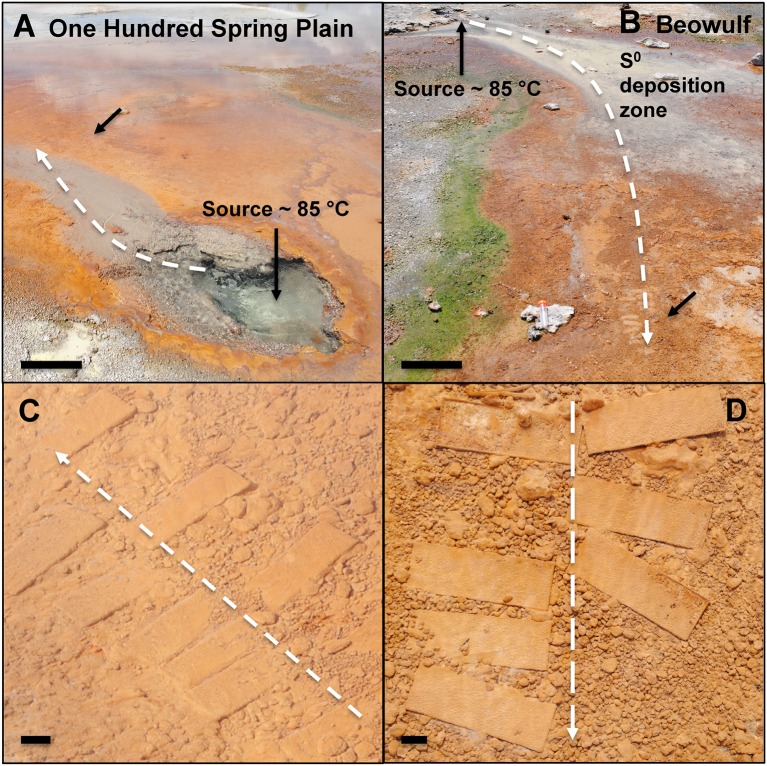
Photographs of One Hundred Spring Plain (A) and Beowulf (B) Springs located in Norris Geyser Basin, Yellowstone National Park, WY, USA (scale bar = 30 cm). The black arrows represent the approximate location of slide placement in the primary outflow channel. Glass slides incubated for 70 days in OSP (C) and Beowulf (D) Springs (scale bar = 1 cm). The dashed white arrows represent direction of flow.